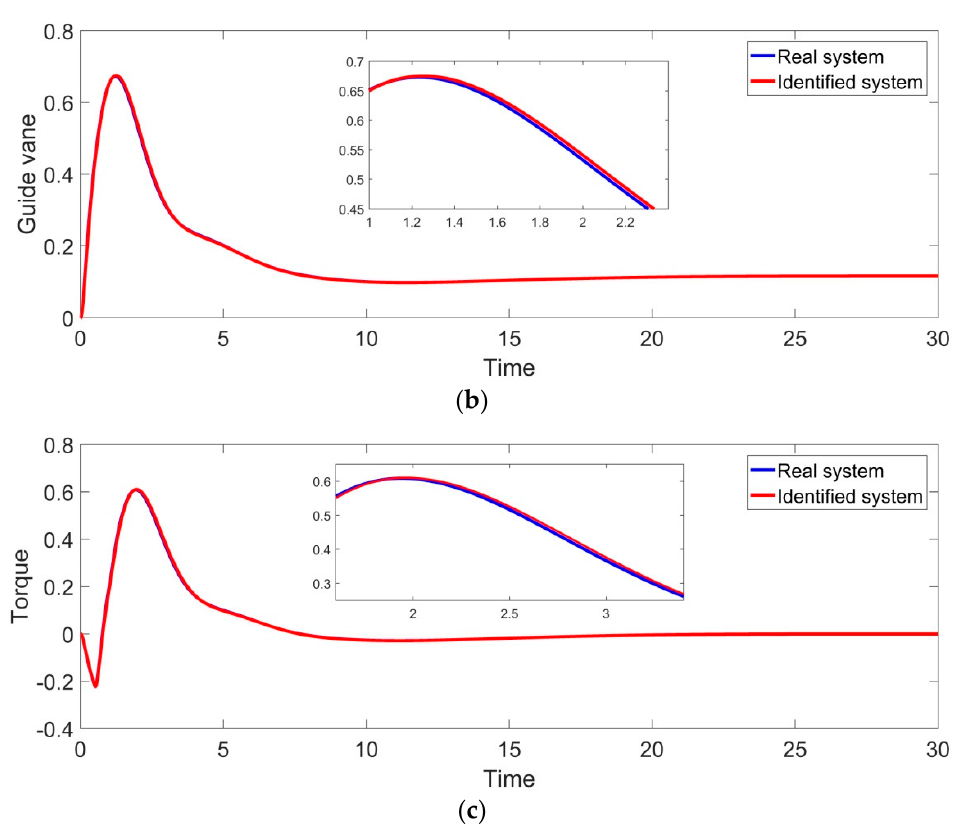
Figure 9. Comparison of system outputs using MSWOA under no-load conditions; ( a ) Comparison curves of turbine speed; ( b ) Comparison curves of guide vane; ( c ) Comparison curves of turbine torque.